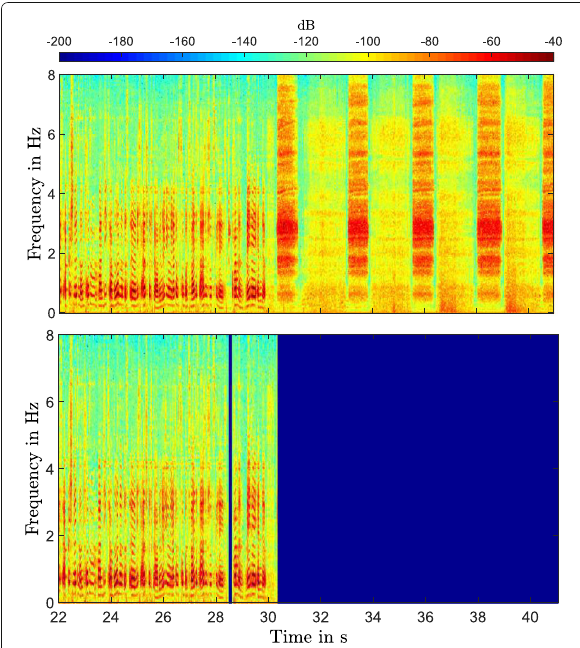
Fig. 11 Spectrogram of recorded microphone data from the communication system without (upper part) and with VAD (lower part), that mutes non-speech